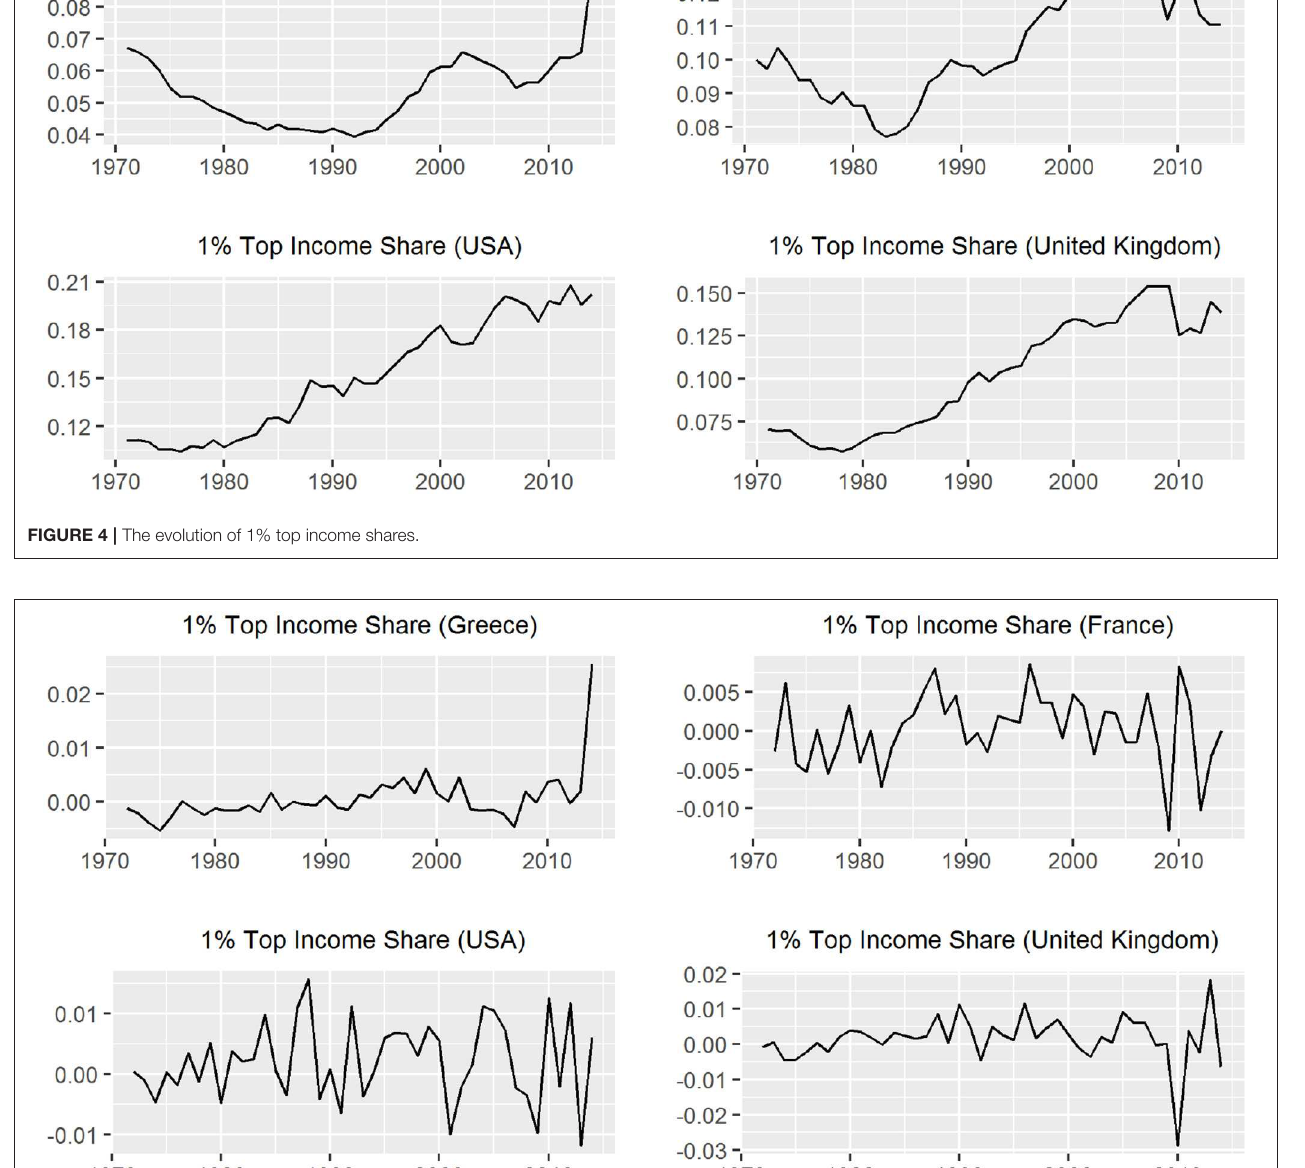
FIGURE 5 | The evolution of first differences of the 1% top income